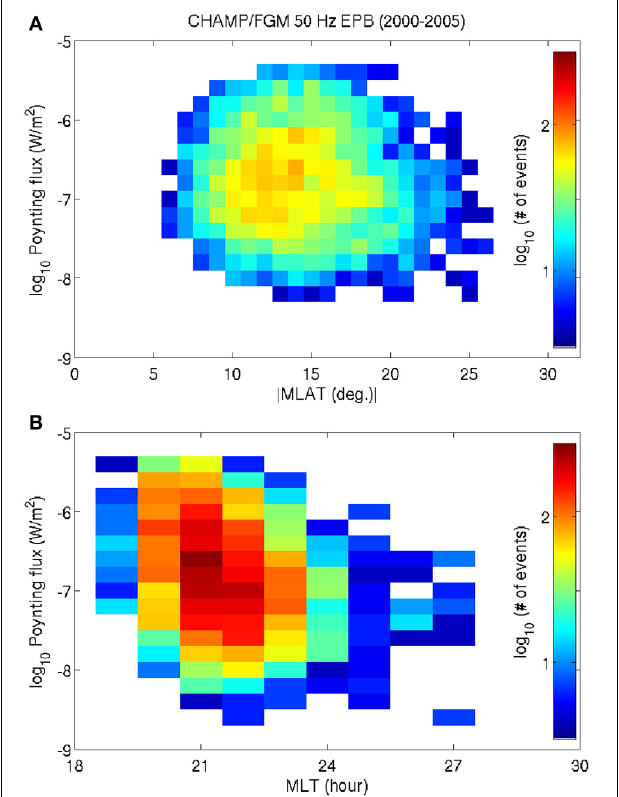
FIGURE 8 | Distribution of Poynting flux level in space and time. (A) Occurrence frequency of Poynting flux vs. magnetic latitude. There is no dependence of flux level on latitude emerging. (B) Occurrence frequency distribution of Poynting flux vs. magnetic local time. Peak occurrence rates appear at successively lower energy levels at later